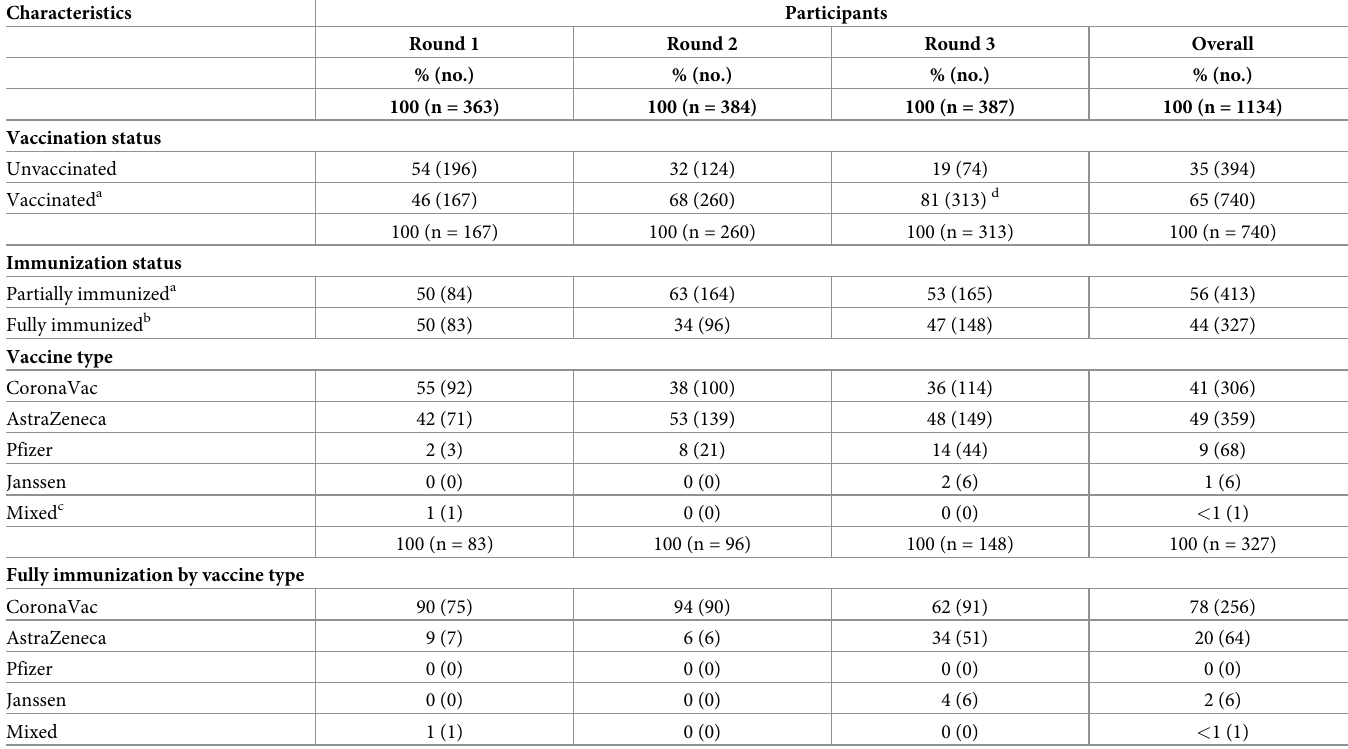
Table 3. Overview of vaccination profile of all participants in the three rounds of the